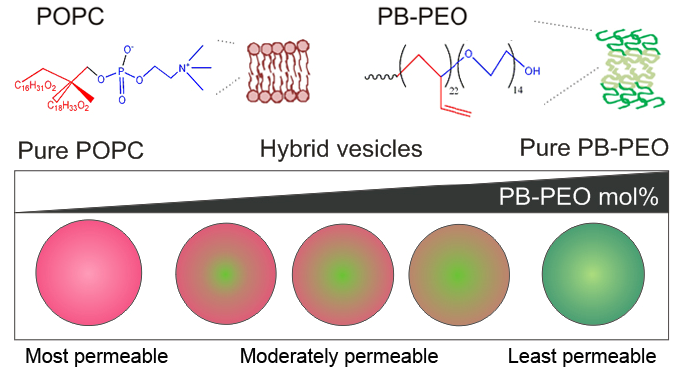
Figure 1. Schematic diagram of nanoscale phospholipid/block copolymer hybrid